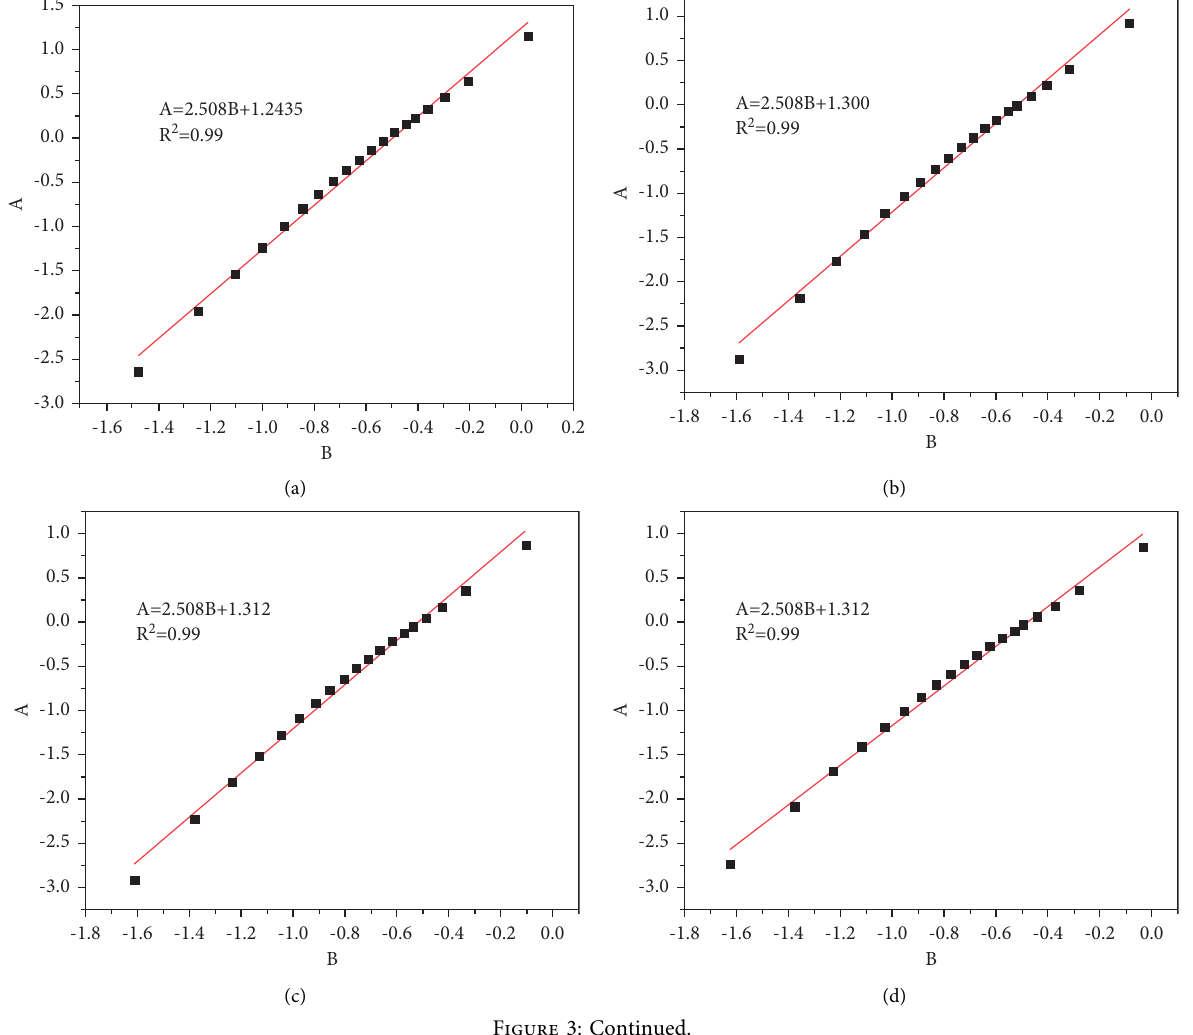
2 adsorption isotherms of the three shale samples. (a) Sample 1. (b) Sample 2. (c) Sample 3.